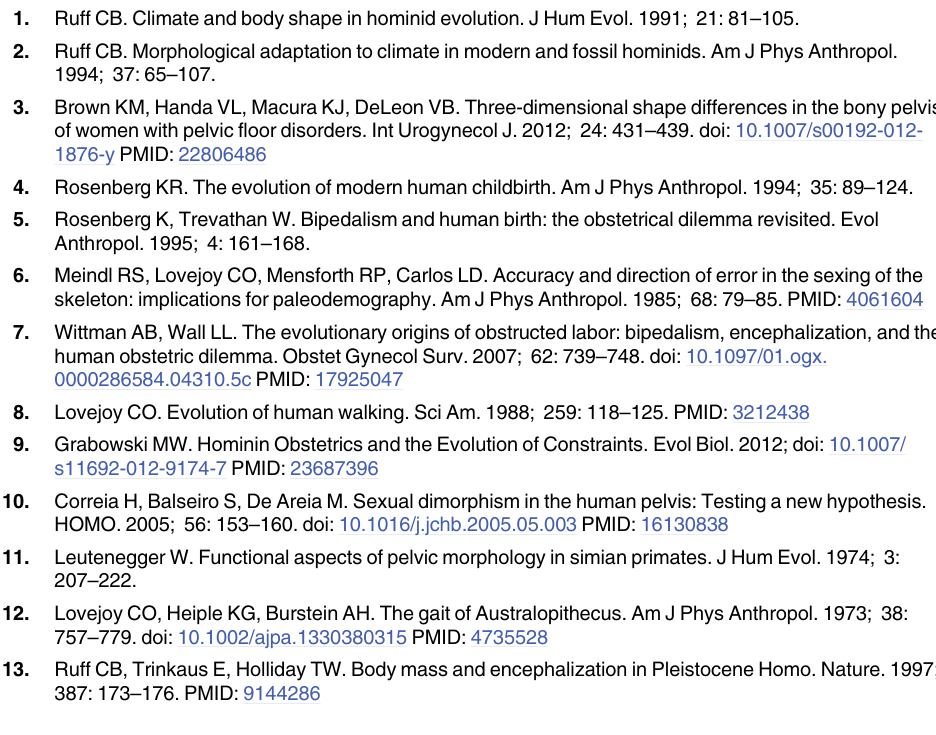
(y = 0.65x – 5.7, R 2 = 0.06, P = 0.28, n = 21). This result is consistent with previous analyses [18]. Lines indicate OLS regressions. (TIF) S3 Fig. Hip abductor r versus femoral neck length and biiliac width. Hip abductor moment arm length, r , is significantly correlated with femoral neck length (y = 1.0x – 0.62, R 2 = 0.62, P < 0.0001) b. and biiliac width (y = 0.32x – 2.9, R 2 = 0.51, P < 0.001) in males (n = 13) and fe- males (n = 13). Lines indicate OLS regressions.